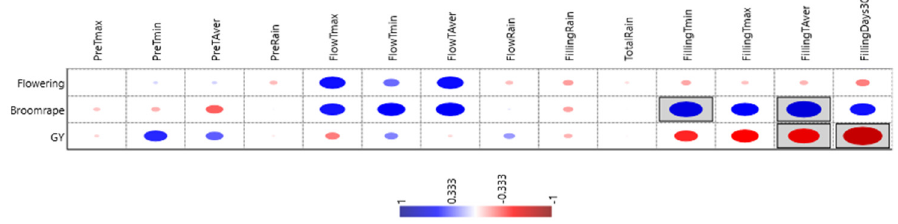
Figure 4. Graphical representation of the effects of climatic parameters on flowering date, broomrape infection, and grain yield. Size of the dot indicates its effect on the trait, blue when positive, red when negative. Only encircled ones are statistically significant.